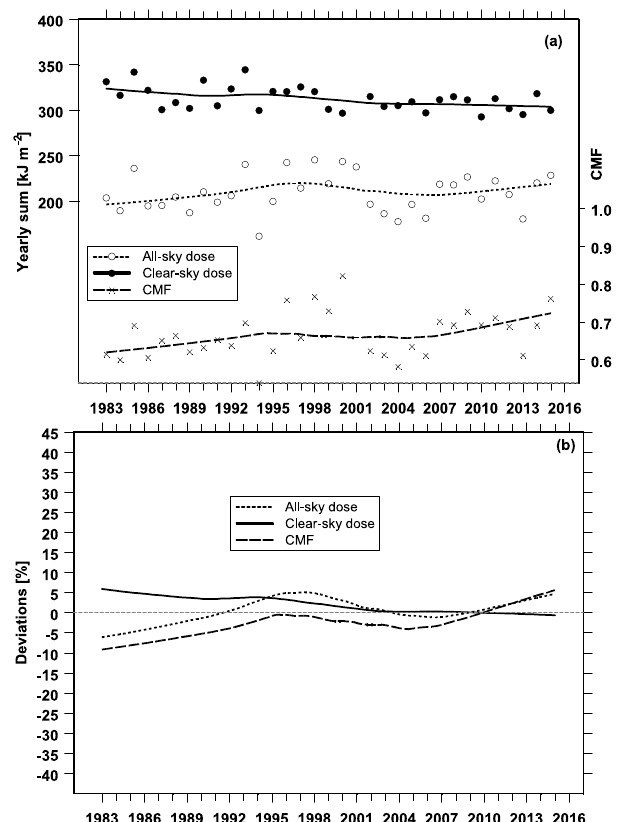
Figure 7. (a) Yearly (March–September) daily sum of erythemal doses in the period 1983–2016: modeled clear-sky values (full cir- cles), observed and modeled all-sky values (open circles), and cloud modification factor (CMF, crosses). (b) Normalized smoothed devi- ations (by LOWES smoother, Cleveland, 1979) of the yearly values shown in Fig. 7a.